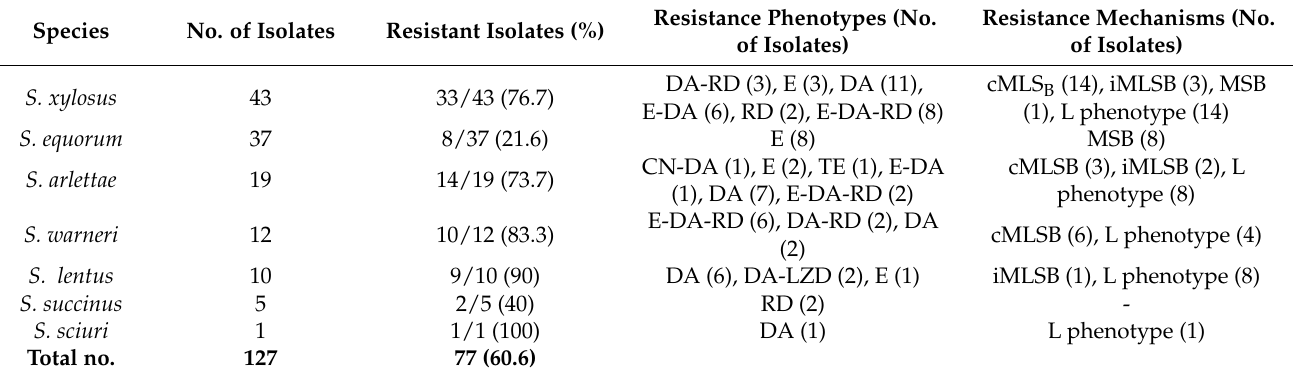
Table 7. Antibiotic resistance of